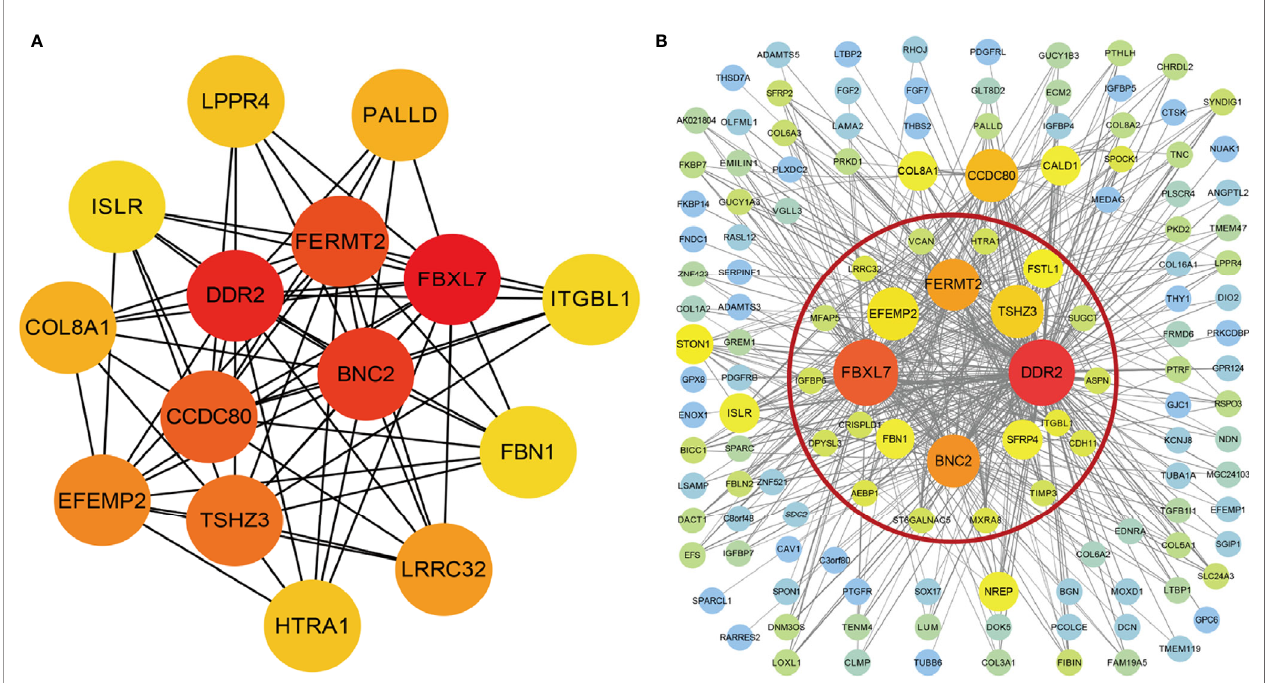
FIGURE 4 | Visualization of the co-expression genes of green-yellow module in Cytoscape. (A) The network containing the top 15 genes ranked by Maximal Clique Centrality (MCC) algorithm of cytoHubba plugins. (B) The top 500 green-yellow module genes based on weight values. The gene module inside red circle was identi fi ed by MCODE